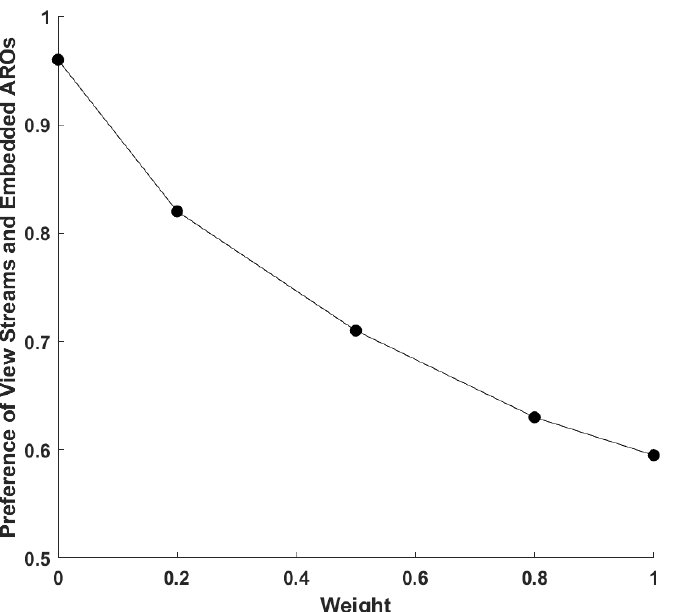
Figure 7. Preference of View Streams and Embedded AROs with Weight µ (6 EC, 30 Requests, EC Capacity is 14 and Total Moving Probability is